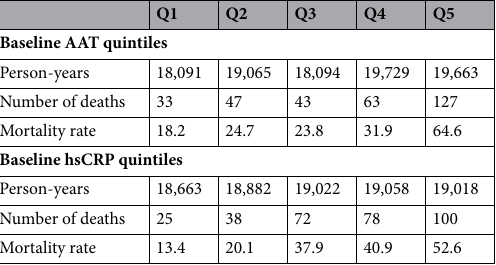
Table 3. All-cause mortality rate by baseline AAT and hsCRP quintiles. The mortality rate is shown per 10,000 person-years. AAT α1-antitrypsin, hsCRP high-sensitivity C-reactive protein.